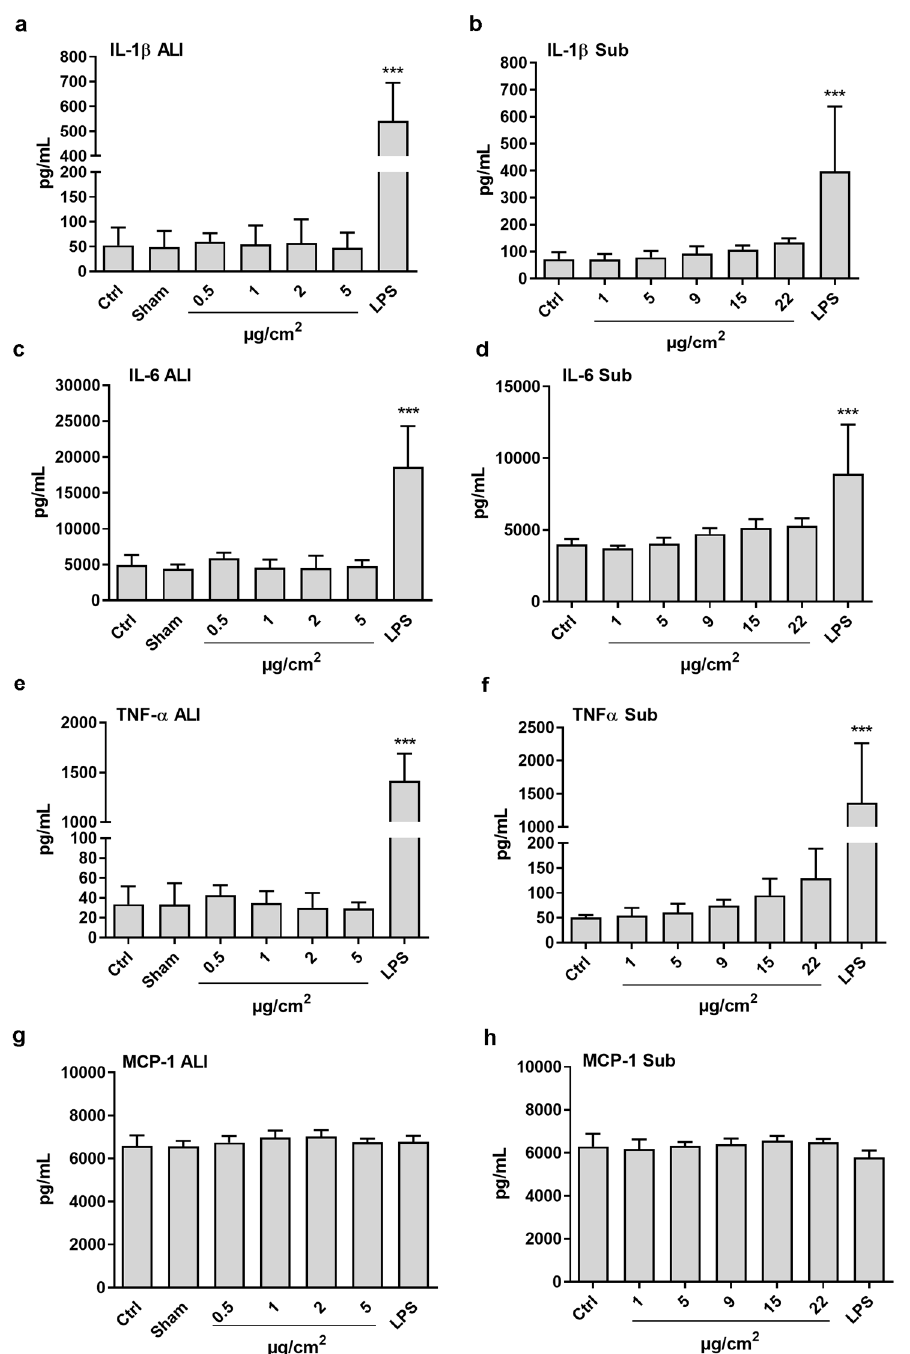
Figure 5. Quantification of cytokine release (IL-1 β , IL-6, TNF α , MCP-1) after 24 h exposure to CeO 2 NPs in air-liquid interface (ALI) ( a , c , e , g ) or in submerged ( b , d , f , h ) co-culture of A549 and THP-1 cells. LPS (100 ng / mL) treatment was used as positive control. The bars represent mean ± SD. Significant results, as compared to the Sham (clean air) for ALI and control (Ctrl) for submerged, are marked with asterisks (*** for p < 0.001).3.5. Cytotoxicity and IL-1 β Release in THP-1 Cells (Monocultures in